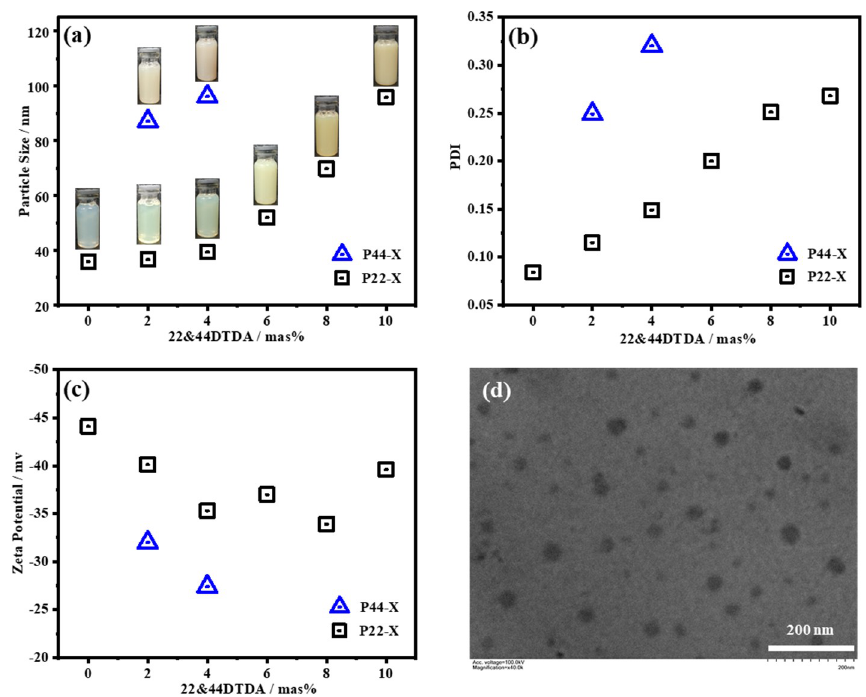
Figure 2. The particle sizes and digital photos of ( a ), the distributions ( b ), the zeta potentials ( c ), WPUR dispersions with various contents of 22DTDA and 44DTDA; ( d ) TEM images of diluted P22- 4.